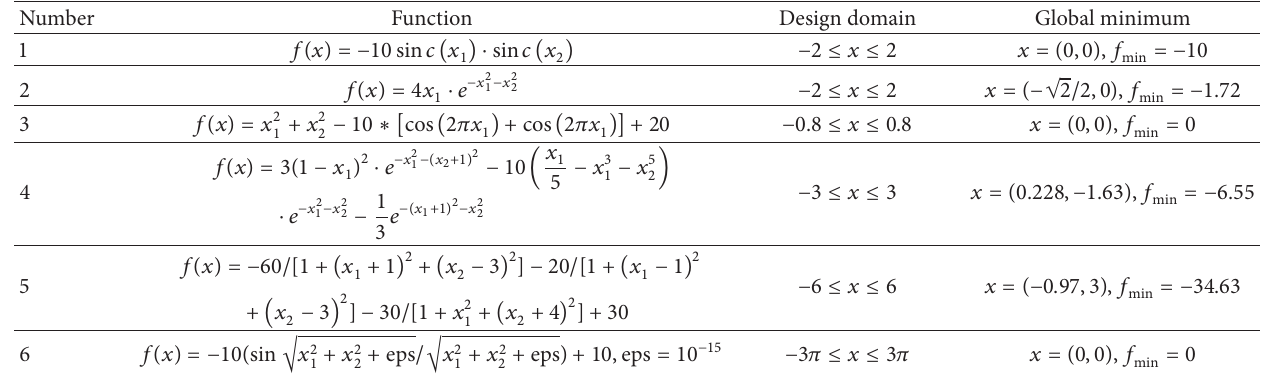
Table 3: Numerical function and global